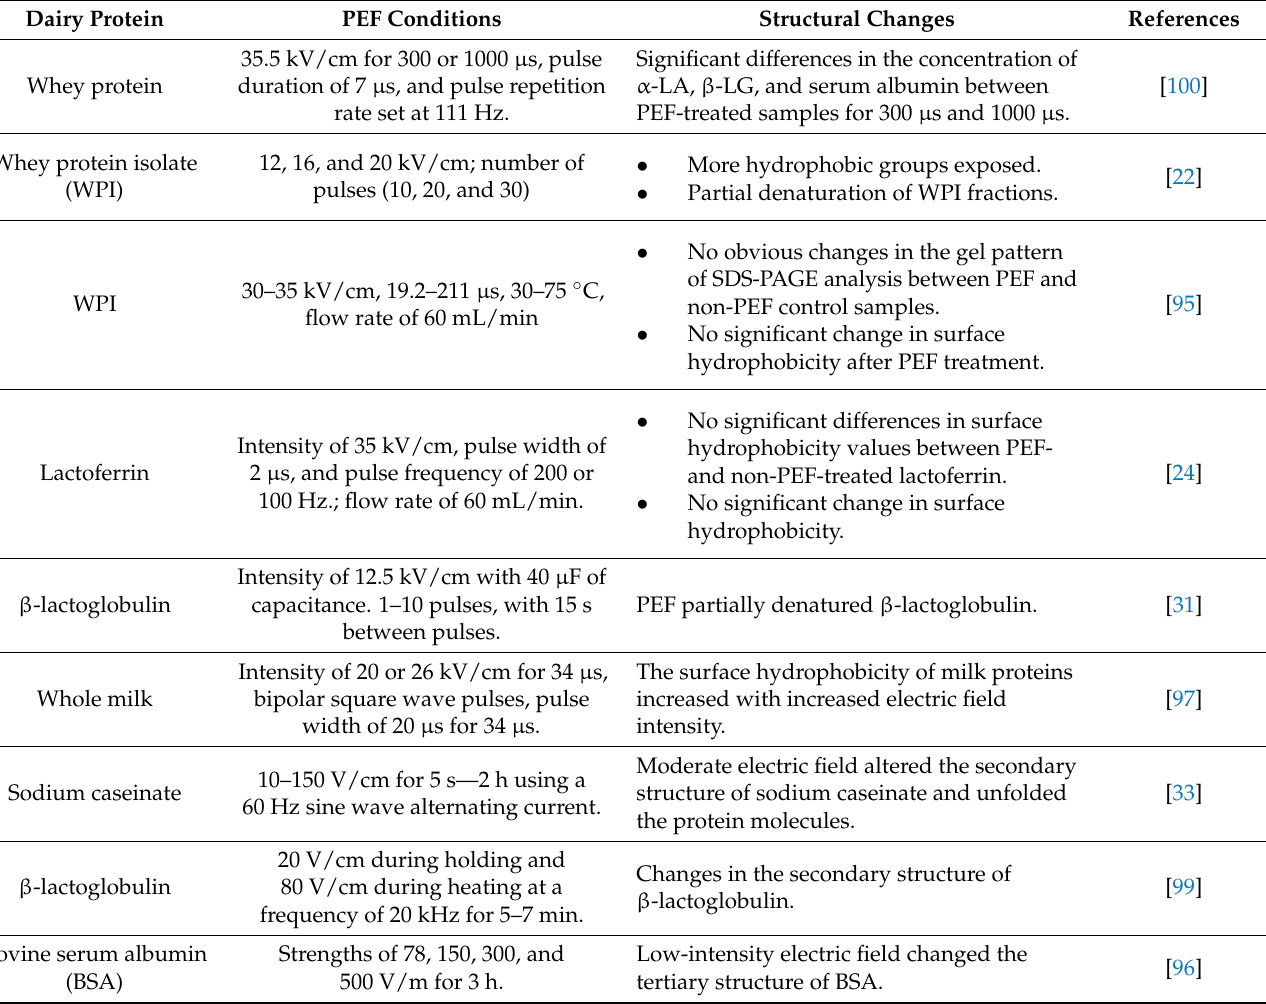
Table 3. Effects of pulsed electric field (PEF) on the structure of dairy